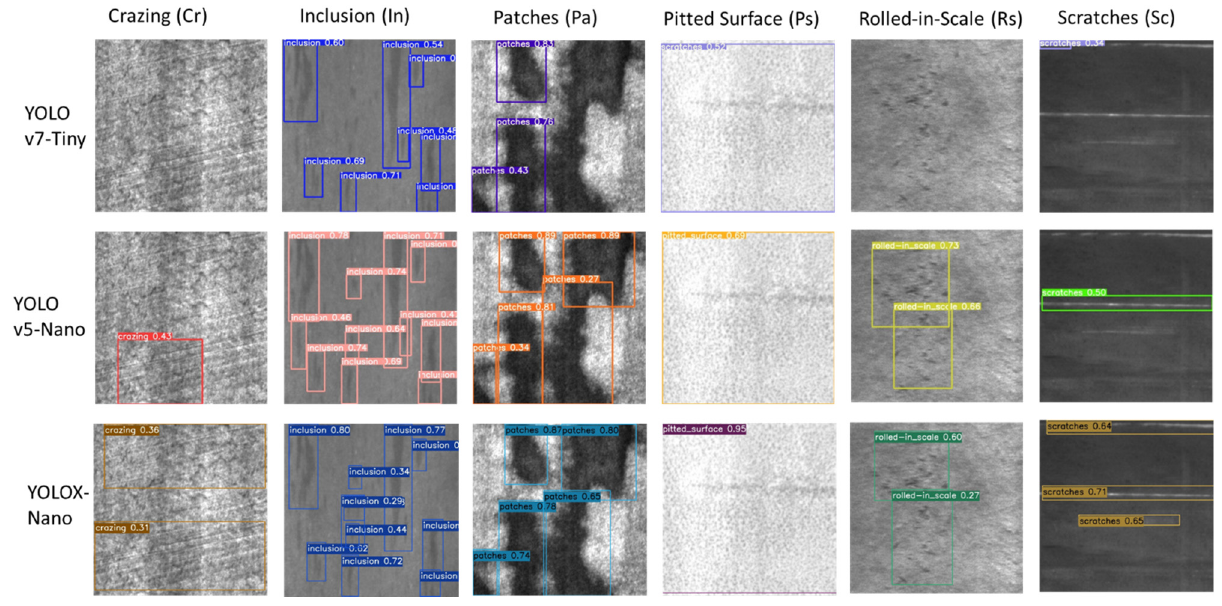
Figure 6. Qualitative Results of three pre-trained YOLO models, including YOLOv7-Tiny, YOLOv5- Nano, and YOLOX-Nano.